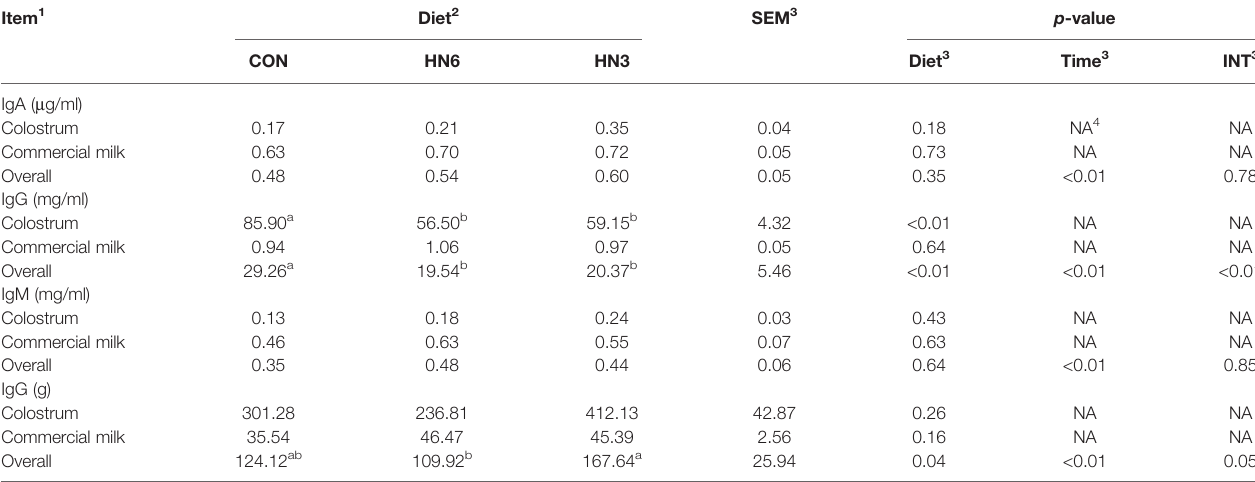
TABLE 2 | Effects of dietary n-6 or n-3 PUFA on milk immunoglobulin of transition cows from 28 days before calving to 28 days postpartum.